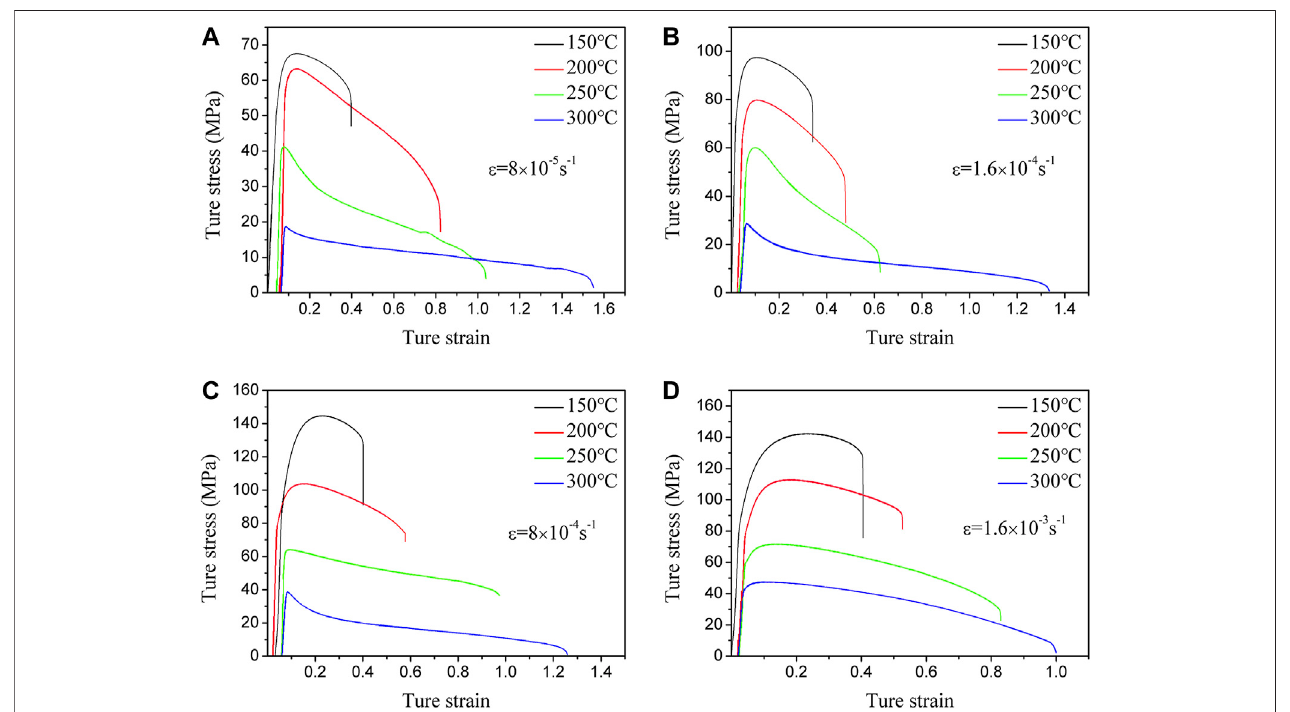
FIGURE 6 | True stress – strain curves of the LAY410 alloy: (A) ε (cid:2) 8 × 10 − 5 s − 1 , (B) ε (cid:2) 1.6 × 10 − 4 s − 1 , (C) ε (cid:2) 8 × 10 − 4 s − 1 , and (D) ε (cid:2) 1.6 × 10 − 3 s − 1 .